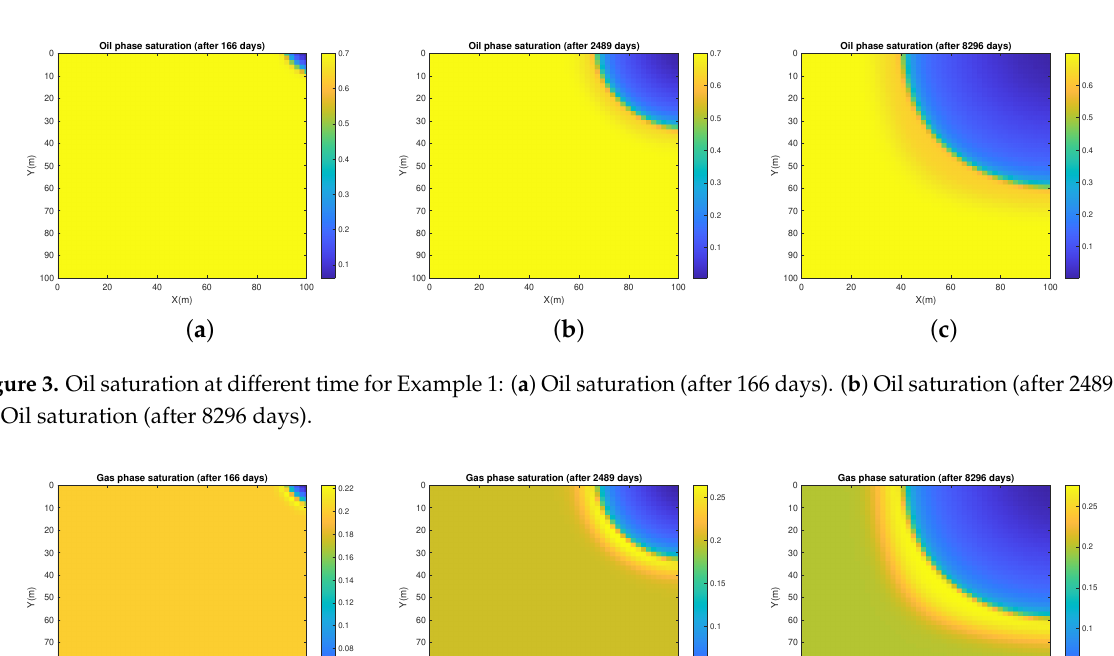
Figure 2. Water saturation at different time for Example 1: ( a ) Water saturation (after 166 days). ( b ) Water saturation (after 2489 days). ( c ) Water saturation (after 8296 days).